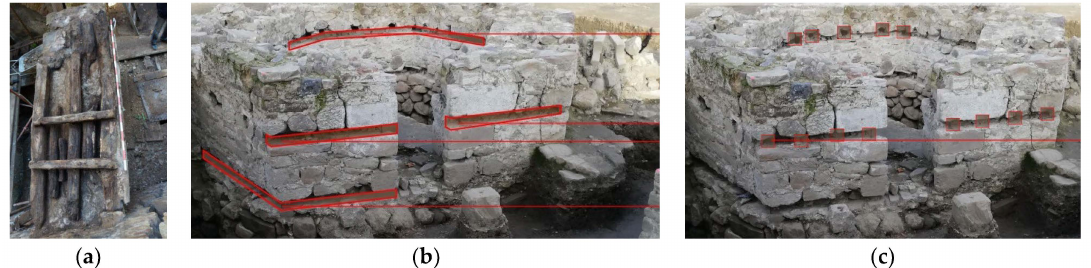
Figure 13. The remains of the tower Dzephana. ( a ) Wooden construction for reinforcement (from Hilandar monastery, identical to the construction of Tower Dzephana). ( b ) Molds of the longitudinal beams on Tower Dzephana. ( c ) Molds of the transversal beams on Tower Dzephana (Photo source: private archive of Vladan